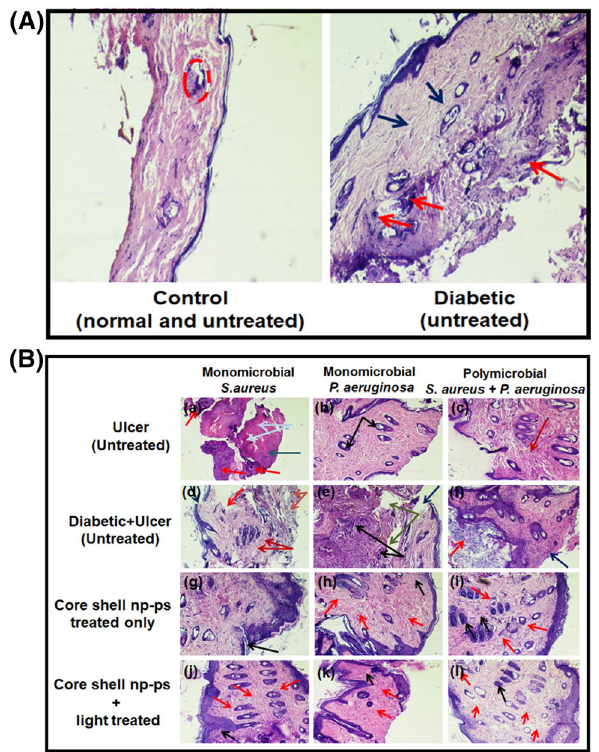
Figure 11. Hematoxylin and Eosin (H& E) (×10X) staining to examine response to microorganism of: ( A ) Control and diabetic rats, ( B ) Ulcerated rats (untreated): figure ( a )–( c ), DFU rats (untreated): figure ( d )–( f ), DFU rats treated with TBO–chit–Au–AgNPs: figure ( g )–( i ) and DFU rats treated with TBO–chit–Au– AgNPs + laser: figure ( j )–( l ). Red dashed line indicates sebaceous gland in Fig. 10( A ) Control group, blue arrow indicates thin collagen fibres while red arrow indicates the locations of neutrophils in diabetic group. In Fig. 10( B ), (a) blue arrow indicates necrosis, grey arrow indicates fibroblasts cells while red arrow indicates dense focal neutrophilic infilterate, (b) black arrow indicates hair follicles, (c) red arrow indicates mild fibrosis, (d) blue arrow indicates ulceration, red arrow indicates collagen fibres, brown arrow indicates thin capillaries while dark brown arrow indicates mild fibrosis, (e) black arrow indicates capillaries, grey arrow indicates collagen fibres while blue arrow indicates ulcer, (f) red arrow indicates squamous epithelium with marked keratosis whereas blue arrow indicates ulcer, (g) black arrow indicates healing ulcer, (h)-(l) red arrow indicates capillaries while black arrow indicates